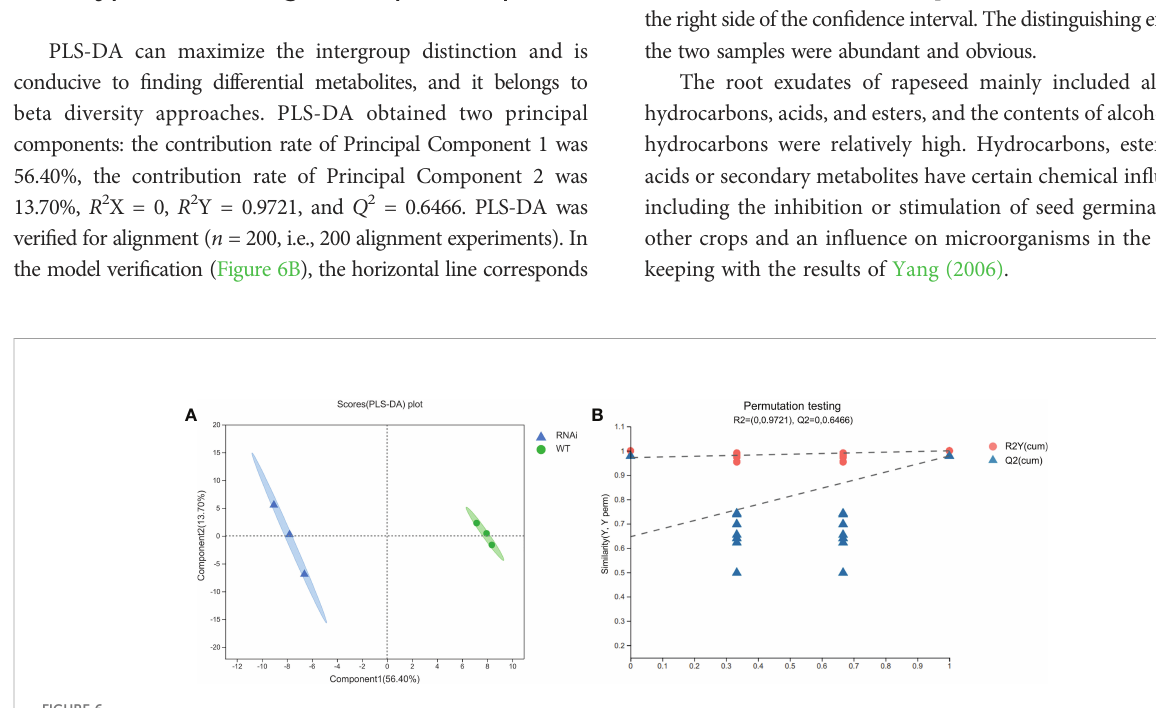
to R 2 Y and Q 2 of the original model, and the red dot and blue dot represent R 2 Y ’ and Q 2 ’ of the model after replacement of y, respectively. R 2 Y ’ and Q 2 ’ were both smaller than R 2 Y and Q 2 of the original model; i.e., the corresponding points did not exceed the corresponding lines, which indicated that the model was meaningful and that its differential metabolites could be screened according to VIP value analysis. According to the PLS-DA model (Figure 6A), 726 metabolome data points were analyzed. The samples of RNAi-T3 were distributed on the left side of the con fi dence interval, and the samples of WT were distributed on the right side of the con fi dence interval. The distinguishing effects of the two samples were abundant and obvious.